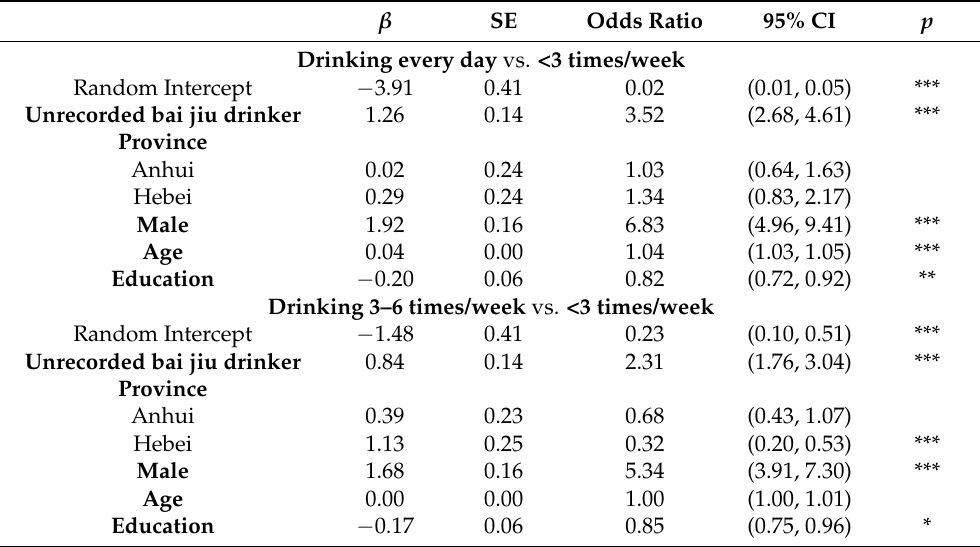
Table 3. Two-level multinomial logistic regression model of the effect of unrecorded bai jiu drinker and province on usual drinking frequency. β